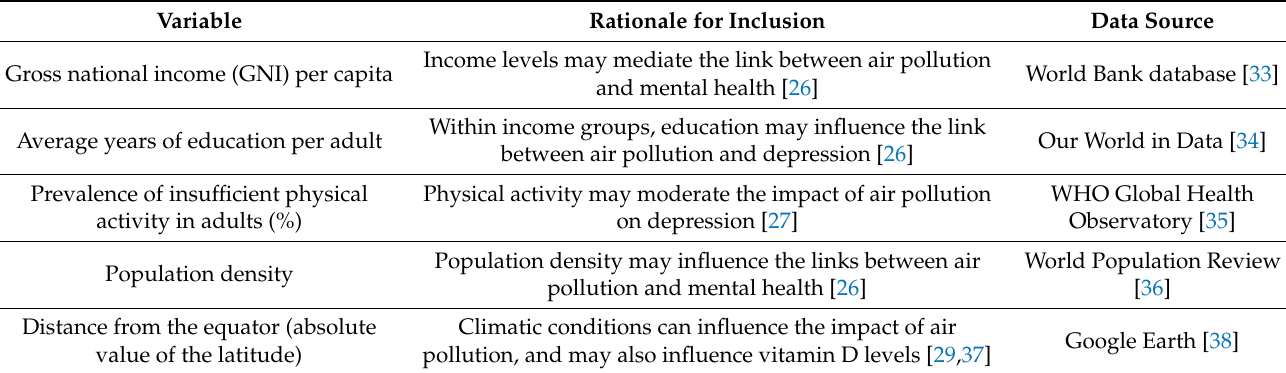
Table 1. Confounding factors analyzed in the current